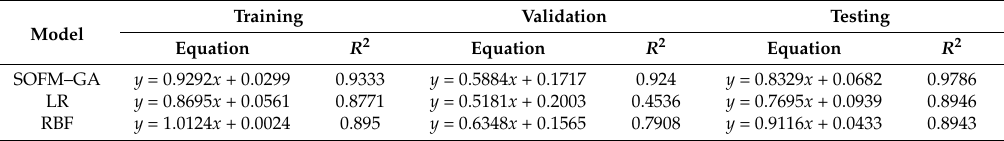
Table 13. Results of the different models in training, validation and testing.